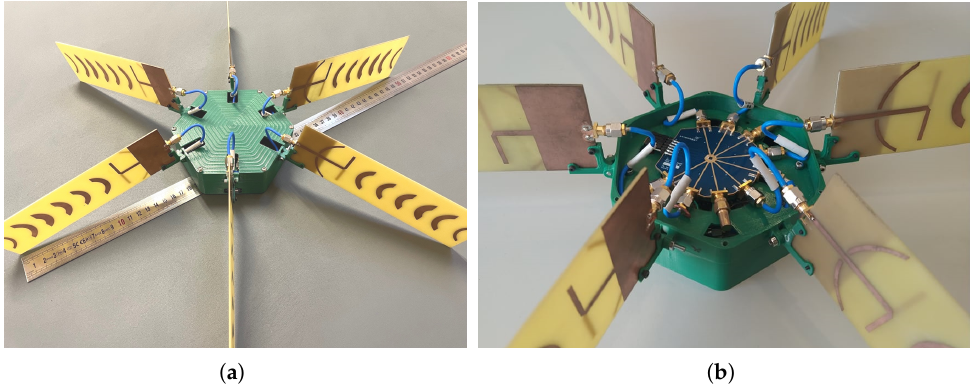
Figure 5. Multi-sector BS: ( a ) complete antenna prototype and ( b ) open view of the SKY13418-485LF RF